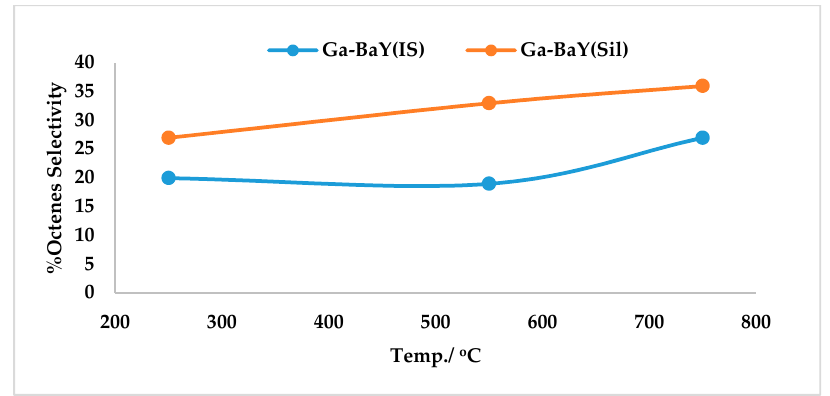
Figure 8. Octene selectivity of Ga-BaY(IS) and Ga-BaY(Sil) calcined at different temperatures.